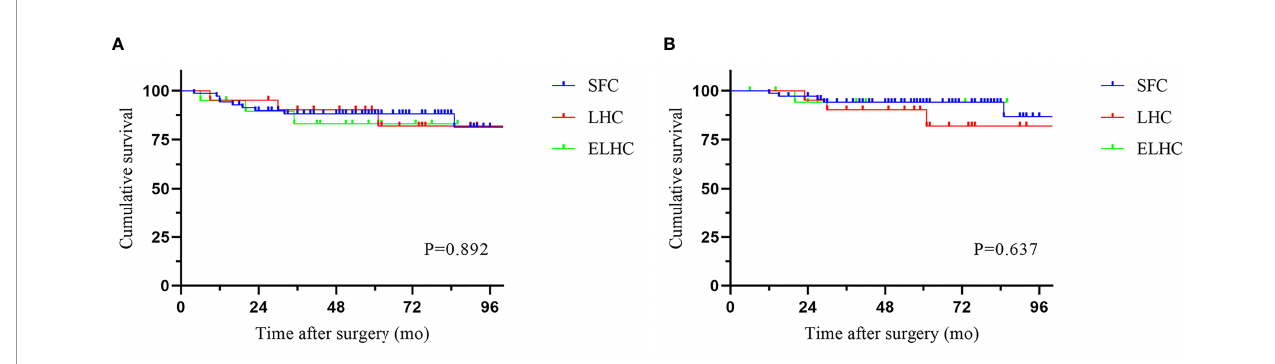
FIGURE 2 | Survival according to surgical procedure. (A) Disease-free survival. (B)